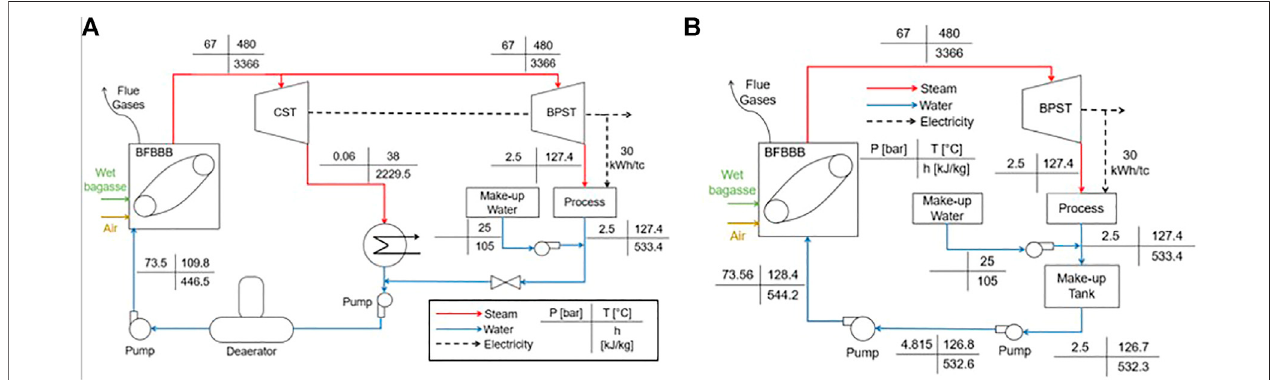
FIGURE 3 | Sugarcane mill cogeneration systems based on: (A) a condensing steam turbine (CST) and a backpressure steam turbine (BPST) with superheated steam conditions at 67 bar/480 ° C, employed in the scenario with no residual bagasse; (B) backpressure steam turbine (BPST) with superheated steam conditions at 67 bar/480 ° C, employed in the scenario with residual bagasse sent to the ammonia plant.